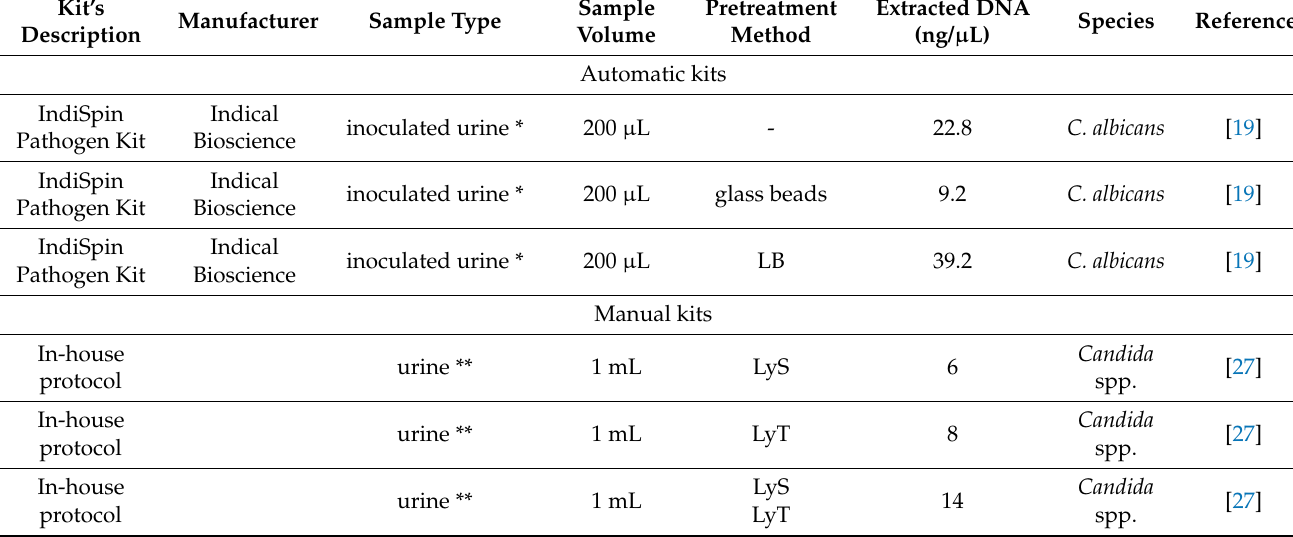
Table 1. Characteristics of the analyzed extraction kits and applied pretreatments for various samples types of superficial Candida spp. infections